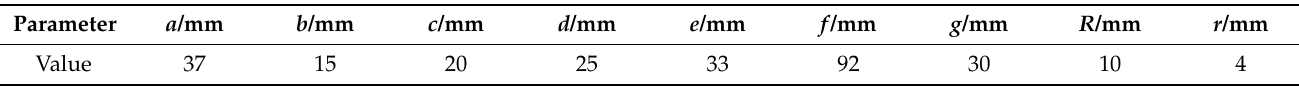
Table 3. List of values for the parameters of the capture and lock mechanism.